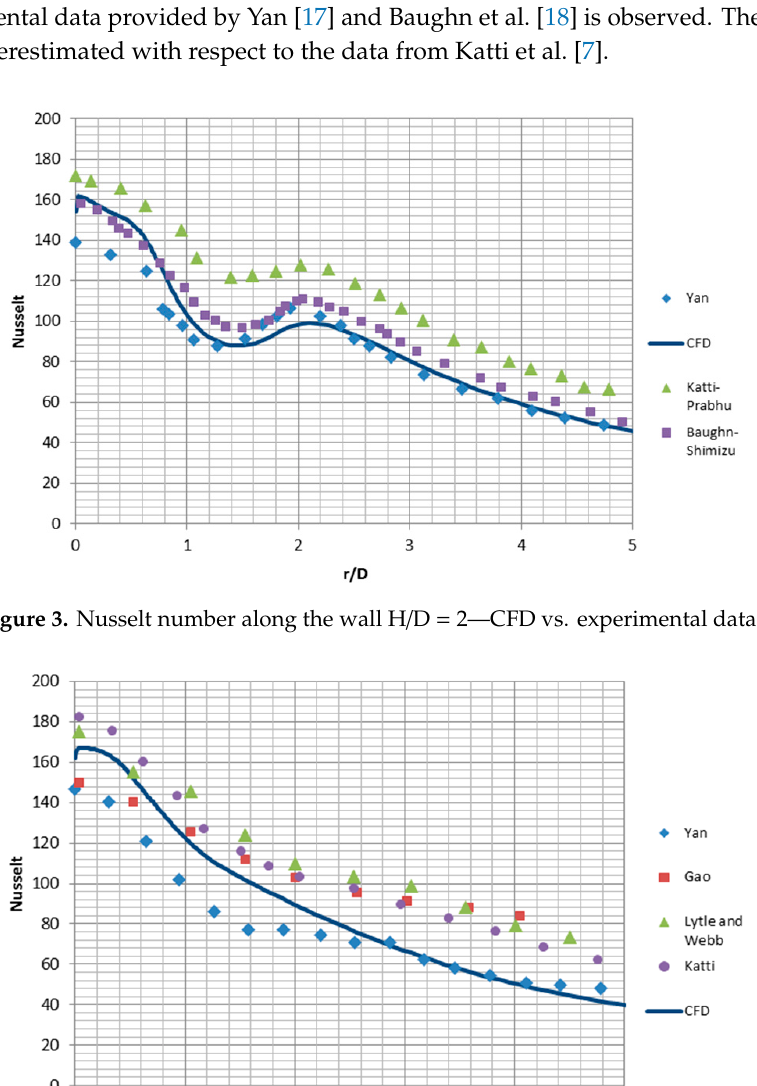
Figure 2. Velocity magnitude contours in case H/D = 2.